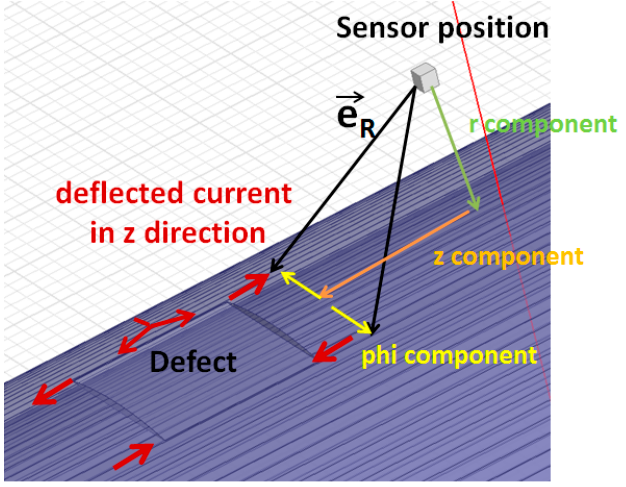
Figure 9. Simplified schematic of rerouted eddy currents in surface of pipe (z components) and directional vector deconvolution.